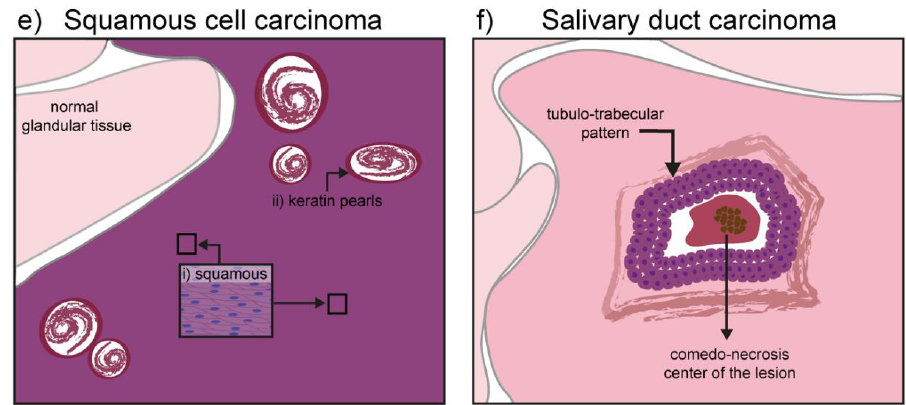
Figure 2. Schematic representation of hallmarks in malignant salivary gland tumors: ( a ) Mucoepidermoid carcinoma might contain three different types of cells depending on its grade: (i) Squamous (epidermoid) cells, (ii) mucocytes, and (iii) intermediate cells. High grade tumors also show necrosis and invasiveness to neighboring tissues (neural and bones); ( b ) adenoid cystic